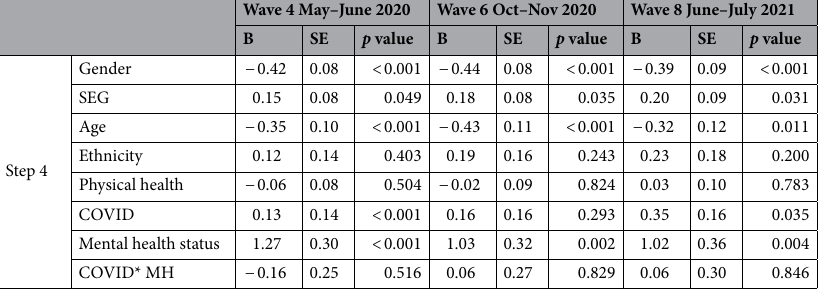
Table 2. Hierarchical regression analyses investigating the associations between probable COVID-19 infection during waves 1–3 (Mar–May 2020) and wellbeing and loneliness at 1 month (May/June 2020), 5 month